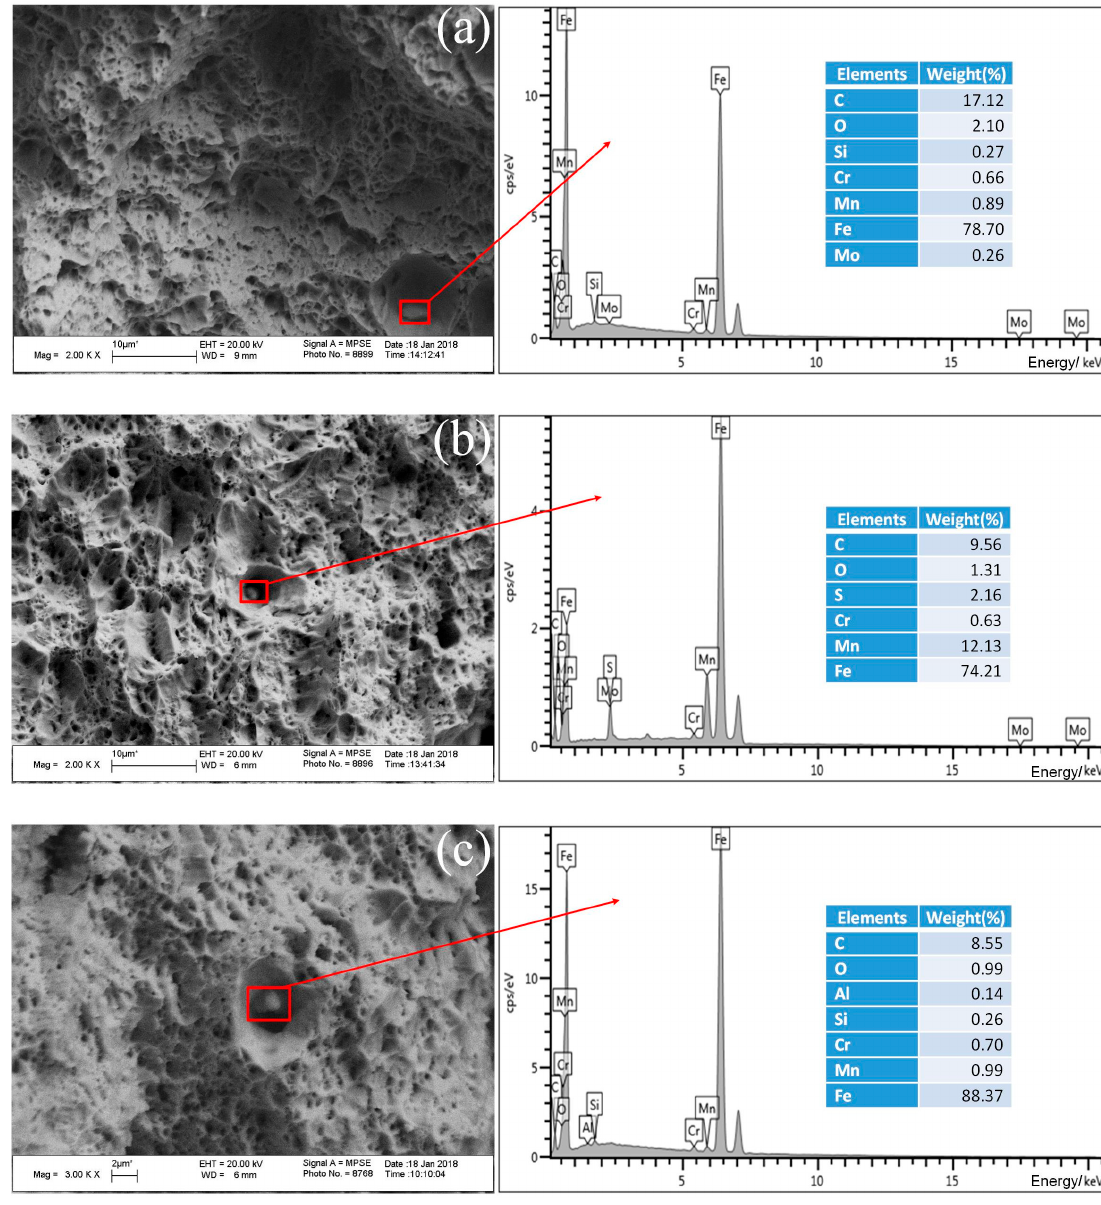
Figure 11. SEM micrographs showing the fracture surface morphology for the tensile test specimens, and the results of EDS (energy dispersive spectroscopy) analysis: ( a ) BM; ( b ) UDW joint; ( c ) ULCW